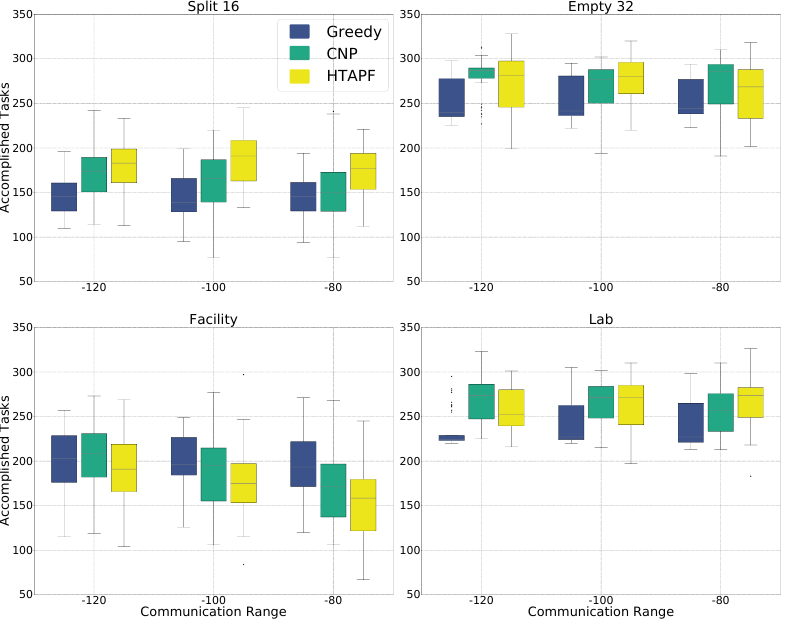
Figure 6. Number of accomplished tasks by the different approaches (greedy, CNP, and HTAPF) across the different environments, obtained with limited communication and no robot